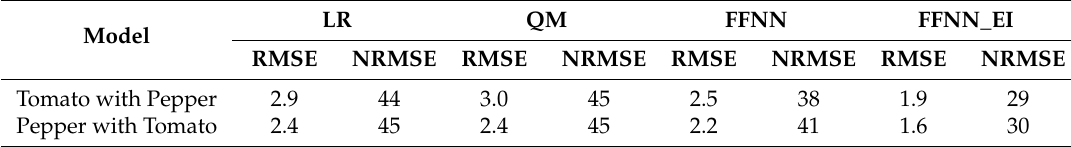
Table 3. Results in (%) of day-ahead forecasting methods using actual